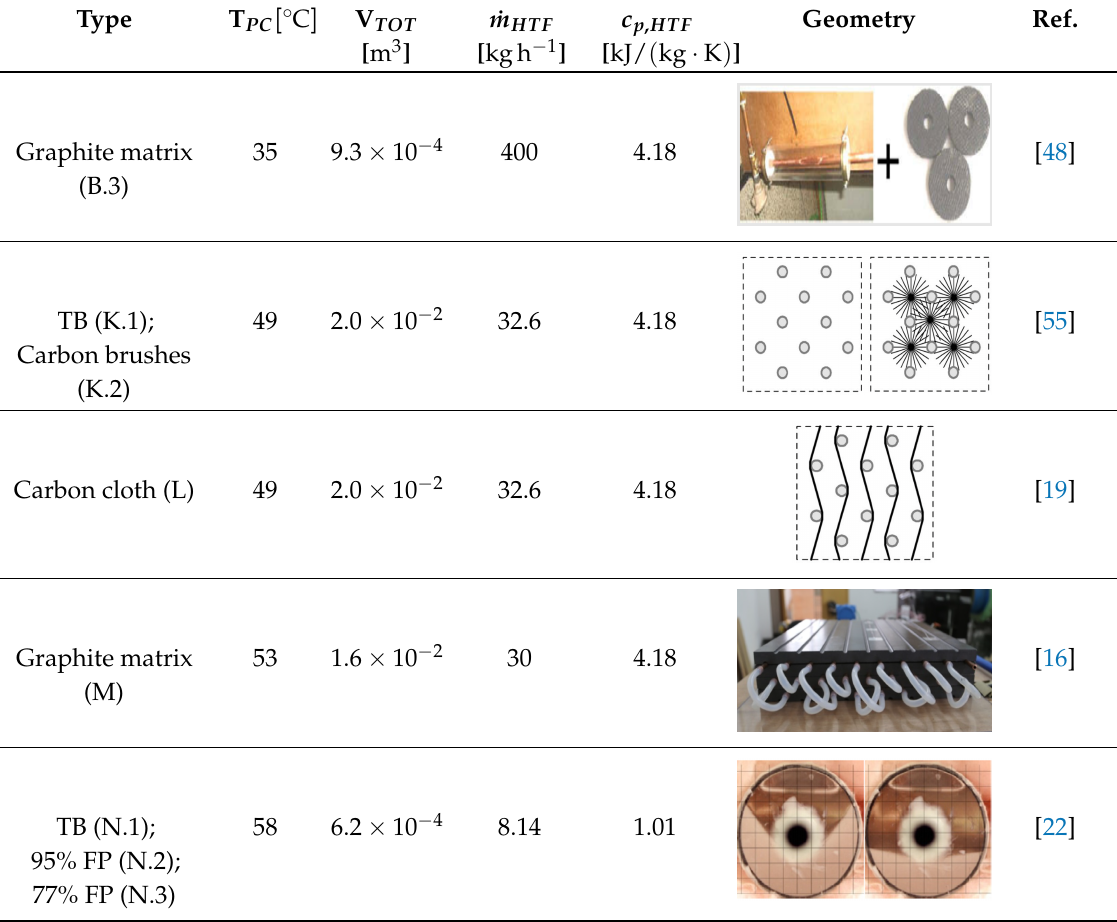
Table 3. References pertaining to carbon based techniques and metal foams as